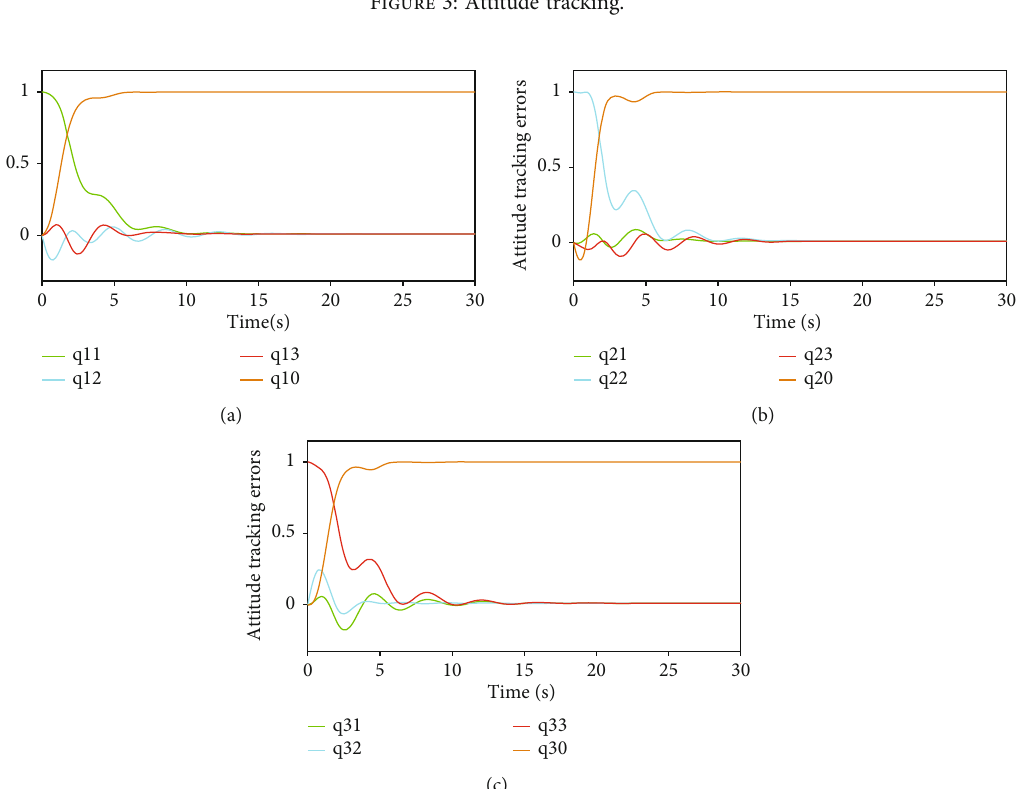
Figure 3: Attitude tracking.